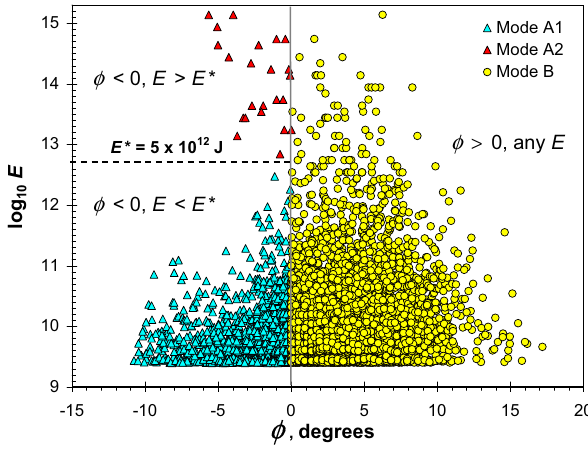
Fig. 2. Scatterplot of emission energies versus relative magnetic latitudes of onset locations for the three modes of emission dy- namics described in the text. The dashed horizontal line marks the crossover energy separating mode A 1 and mode A 2 events.